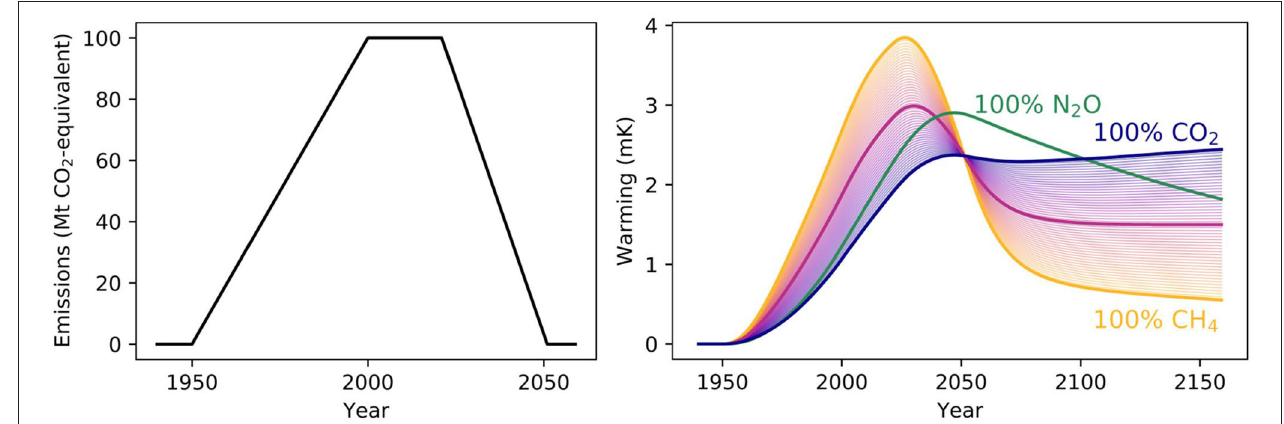
FIGURE 1 | A single emissions pathway (left) reported as CO 2 -equivalents using the 100-year Global Warming Potential (GWP100) can have very different impacts (right) depending on the gas-specific composition, illustrated by showing the warming contribution if the CO 2 -equivalent emissions are entirely nitrous oxide (green), entirely carbon dioxide (blue), entirely methane (orange), or various combinations of carbon dioxide and methane (blue-to-orange spectrum; 50% methane, 50% CO 2 shown as stronger purple